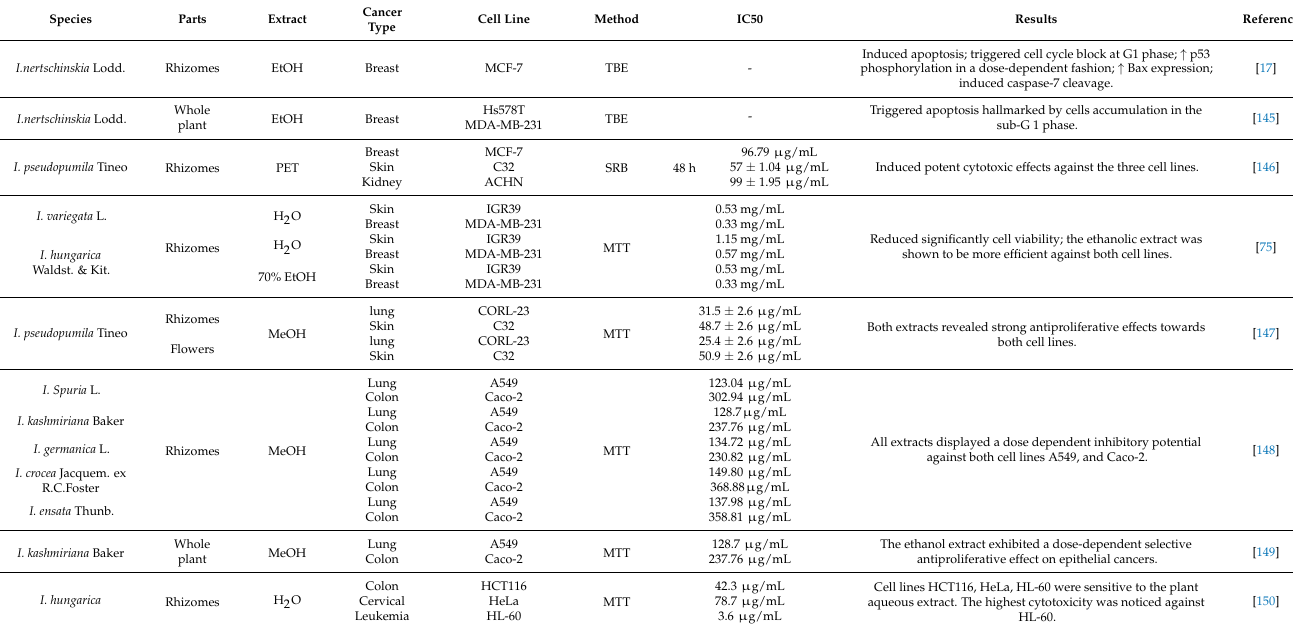
Table 6. In vitro anticancer and cytotoxic activities of Iris spp. extracts against various cell